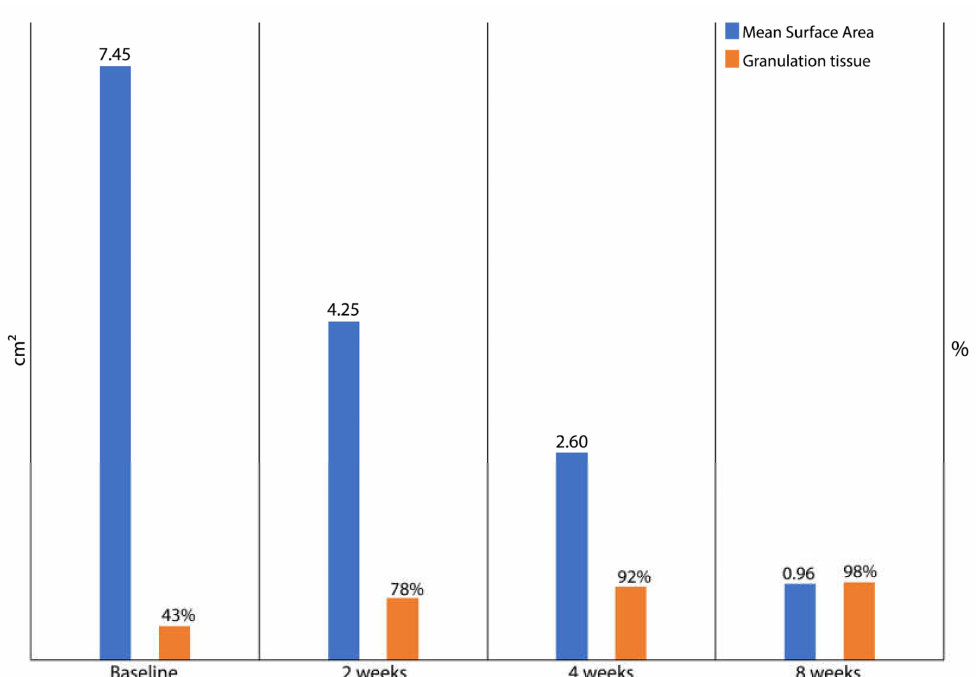
Figure 1. Progression of wound healing during the treatment with an ointment based on hyaluronic acid and silver sulfadiazine, as measured by the mean wound surface area and the overall mean percentage of granulation tissue. The mean wound surface area decrease is inversely proportional to the increase in the percentage of granulation tissue.